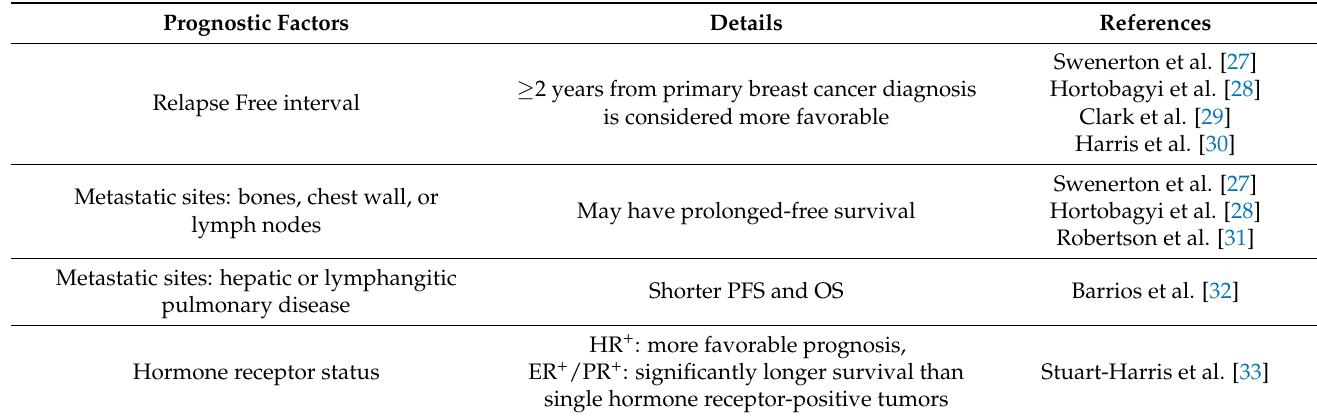
Table 1. Prognostic and Predictive factors for metastatic Breast